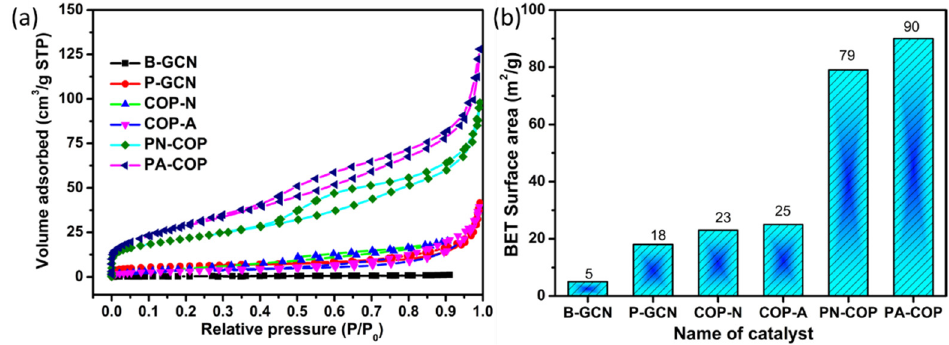
Figure 9. ( a ) N 2 adsorption/desorption isotherms of the catalysts ( b ) histogram representing the sur- face area of the different